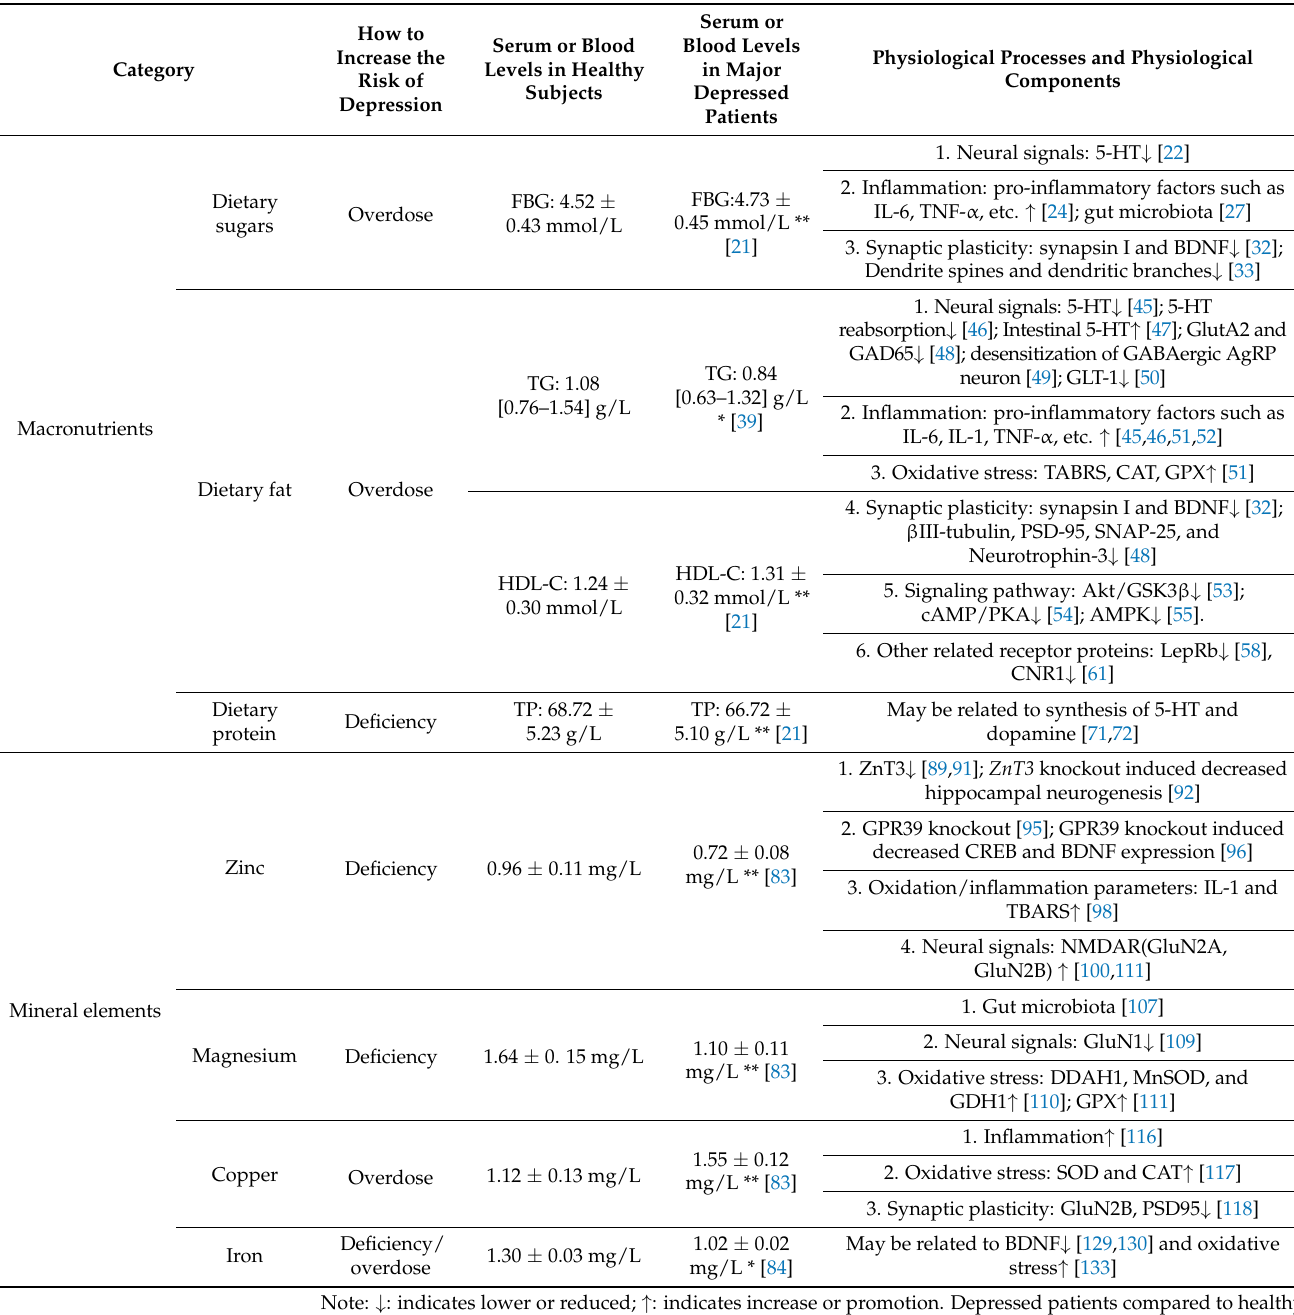
Table 1. Summarize the possible mechanism for overdose or deficiency of macronutrients and mineral elements to increase the risk of